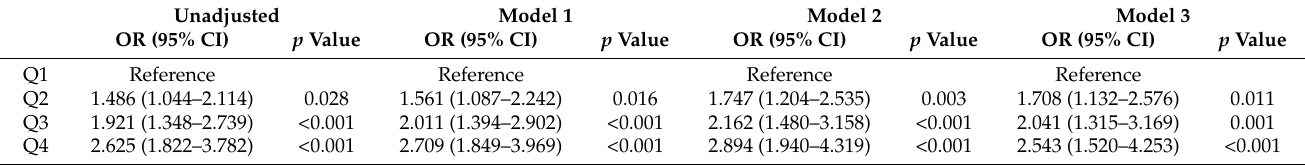
Table 3. Logistic regression analyses showing the predictive value of TyG index for VDD